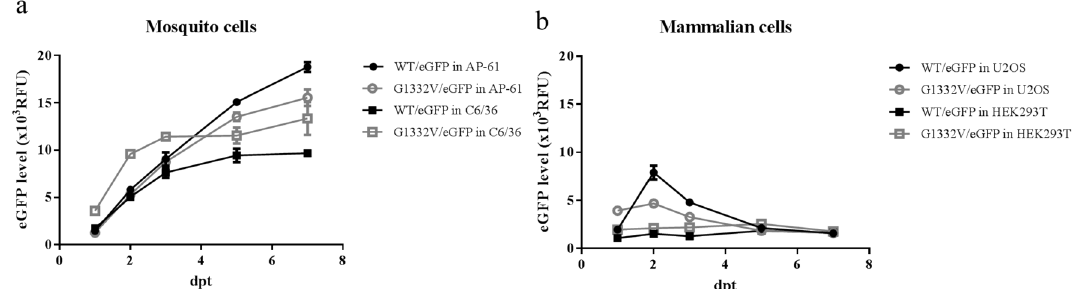
Figure 8. Time course of CHIKV replicon-mediated eGFP expression of replicon variants in mosquito cell lines ( a , AP-61 and C6/36) or mammalian cell lines ( b , U2OS and HEK293T) following transduction in triplicate using a recombinant baculovirus at an MOI of 2 or 10, respectively. Expression levels of eGFP were quantified at 1, 2, 3, 5, and 7 dpt. Error bars represent the standard